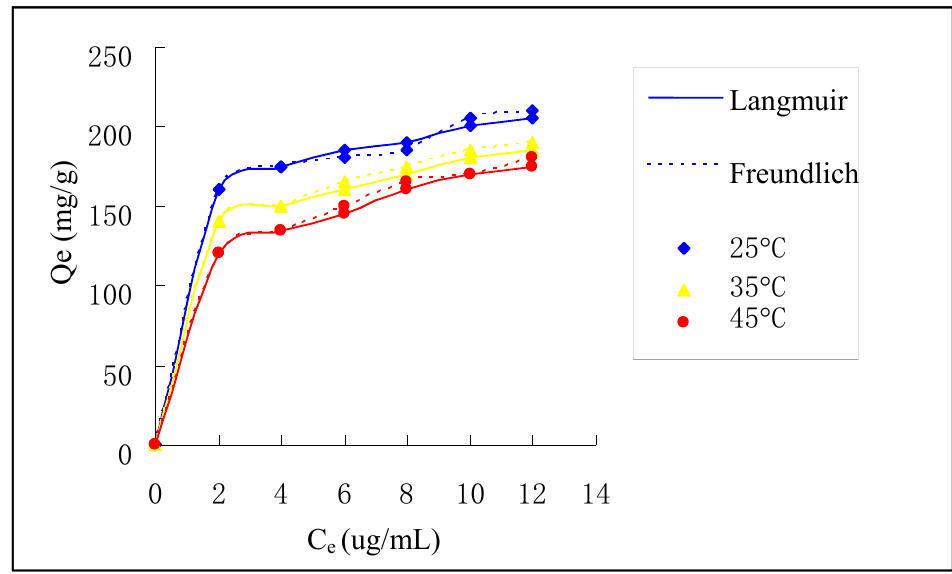
Figure 6. Adsorption isotherm of Cr(VI) on